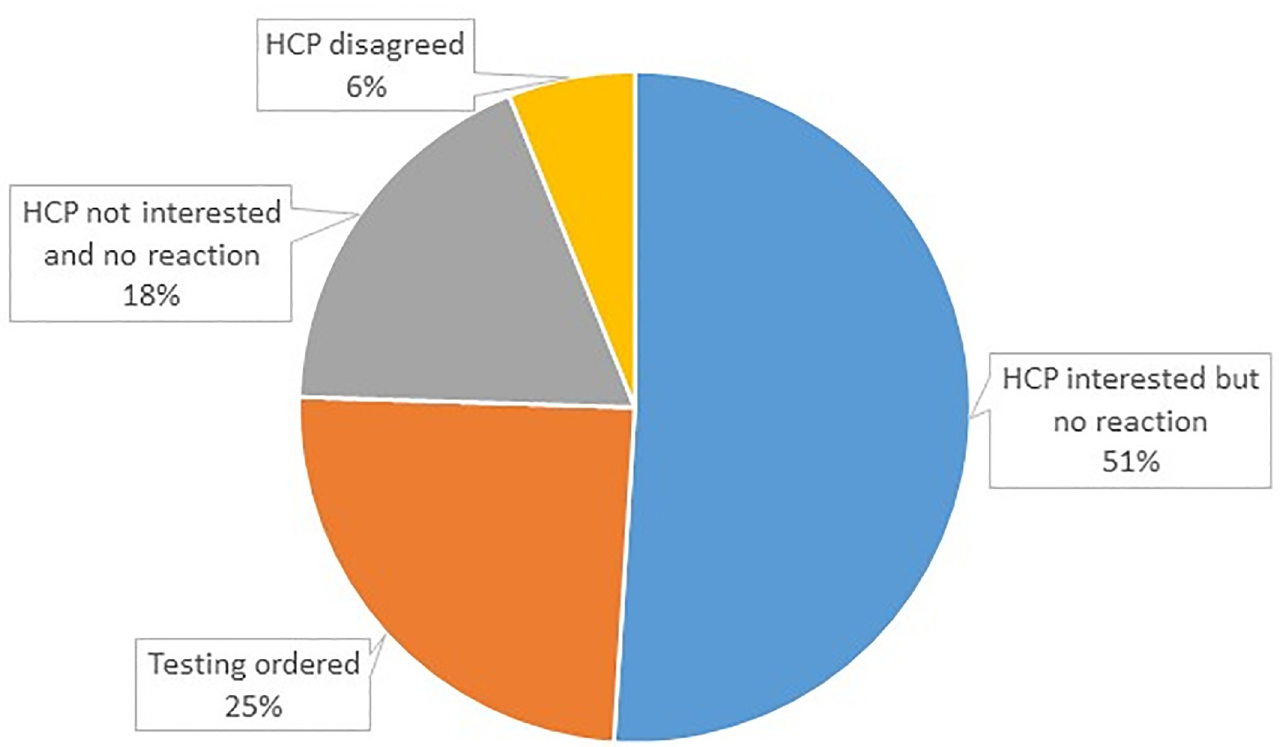
Fig 1. Health care provider response to sharing screening results. Thirty-three percent of participants shared the results of their screening with their health care providers. When asked to describe what the providers response was, 25% reported that their providers ordered additional tests and initiated a work-up to establish a diagnosis. Participants reported that 6% of providers disagreed with the results of the screening visit and took no further action, while 18% of providers were not interested in reviewing the results of the screening visit. Participants reported that 51% of providers discussed the results of the screening visit with the participant but took no further action with the proportion tending to be higher in those who were found to be cognitive impaired based on both objective and subjective tests compared to those who were not impaired (60.5% vs. 18.2%, p =